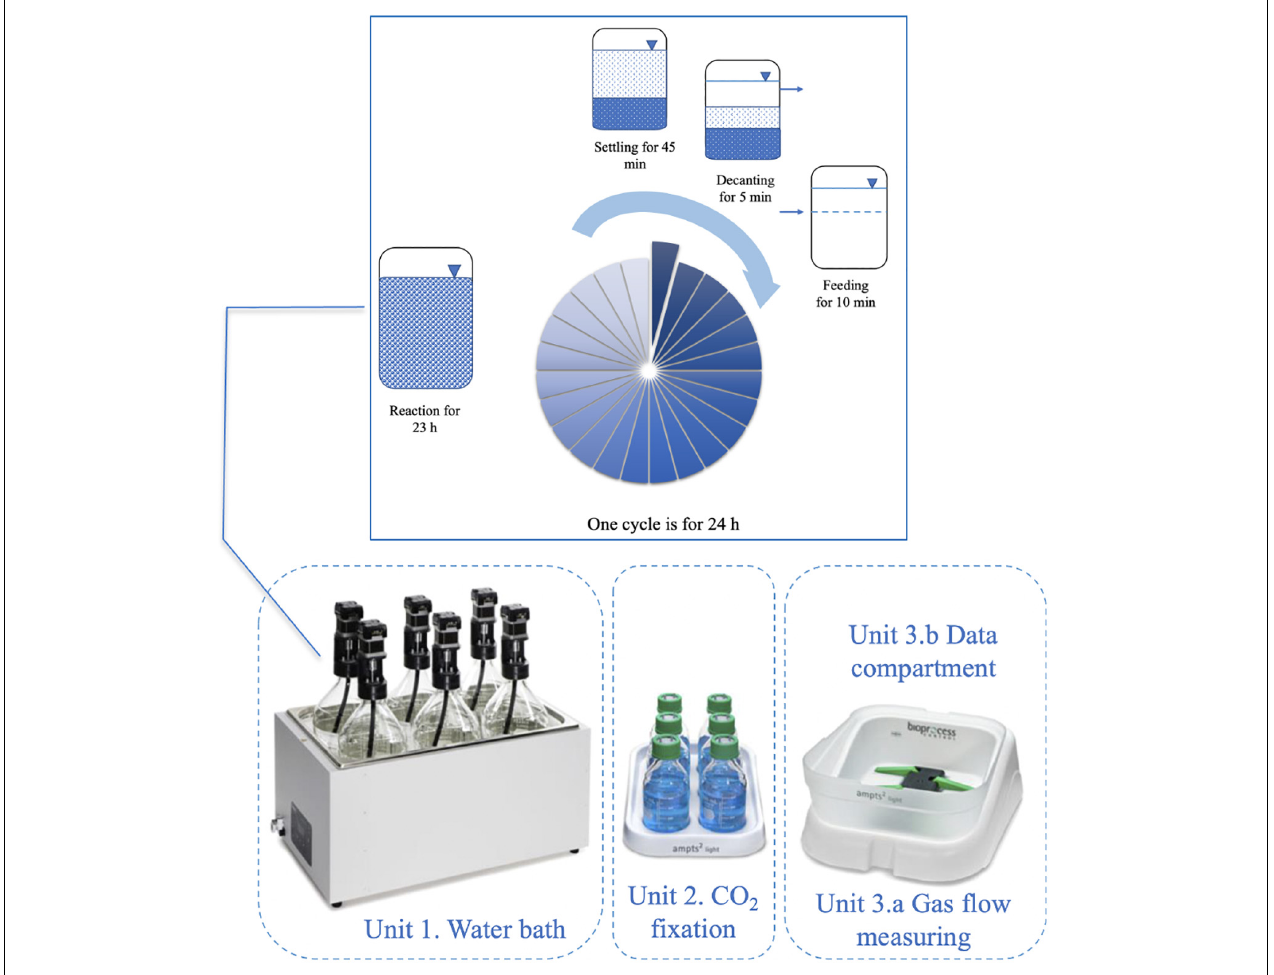
FIGURE 1 | The AMPTS II System (Bioprocess Control, Sweden) for anaerobic sequencing batch reactors and detailed operation